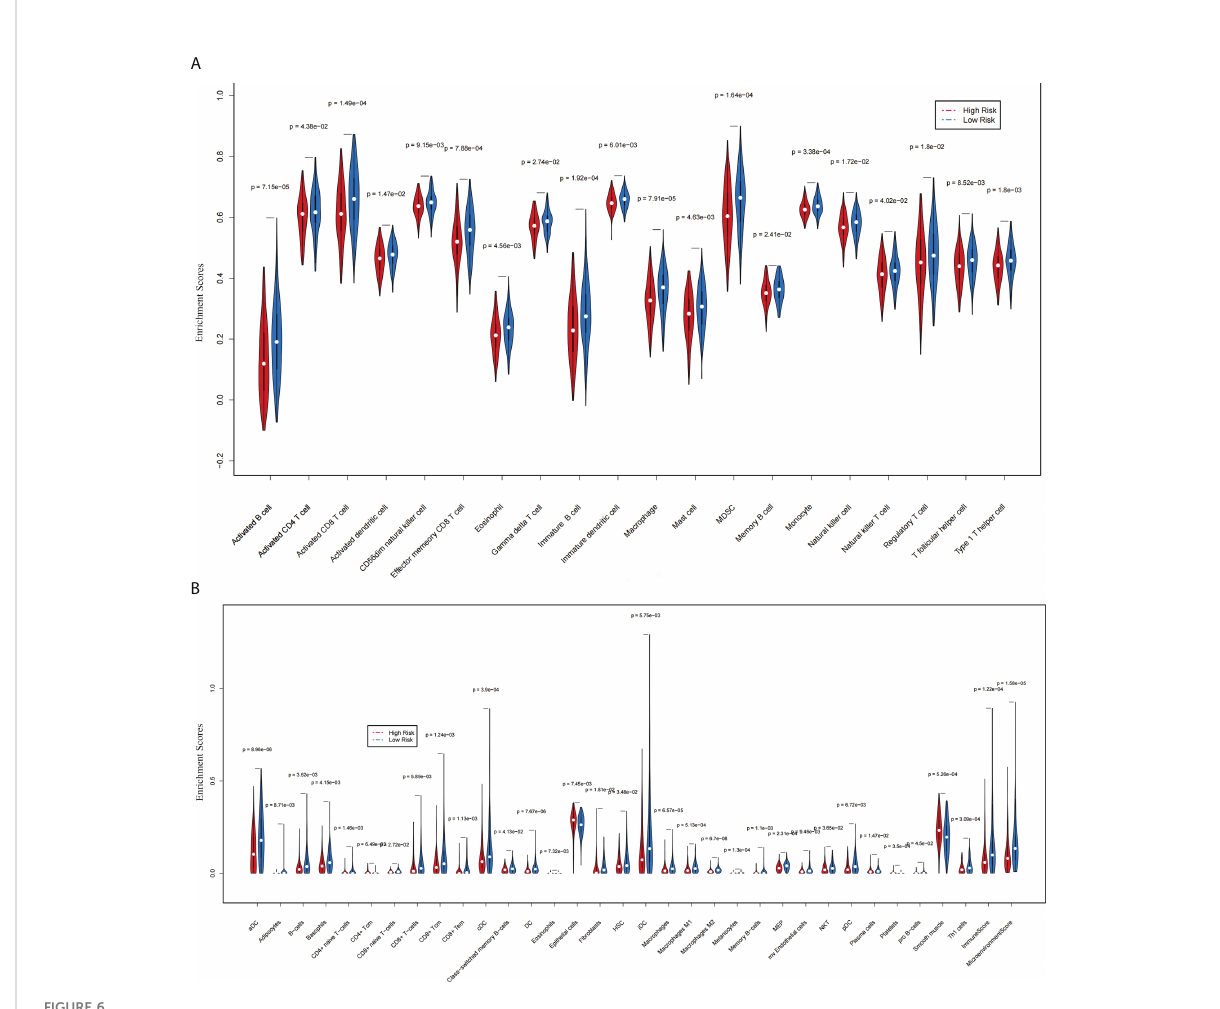
FIGURE 6 The association between two prognostic NRLs and immune in fi ltration (xCell and ssGSEA). (A) The violin plot which revealed that the immune cell expressions were different in two groups via ssGSEA. (B) The violin plot which revealed that the immune cell expressions were different in two groups via the xCell